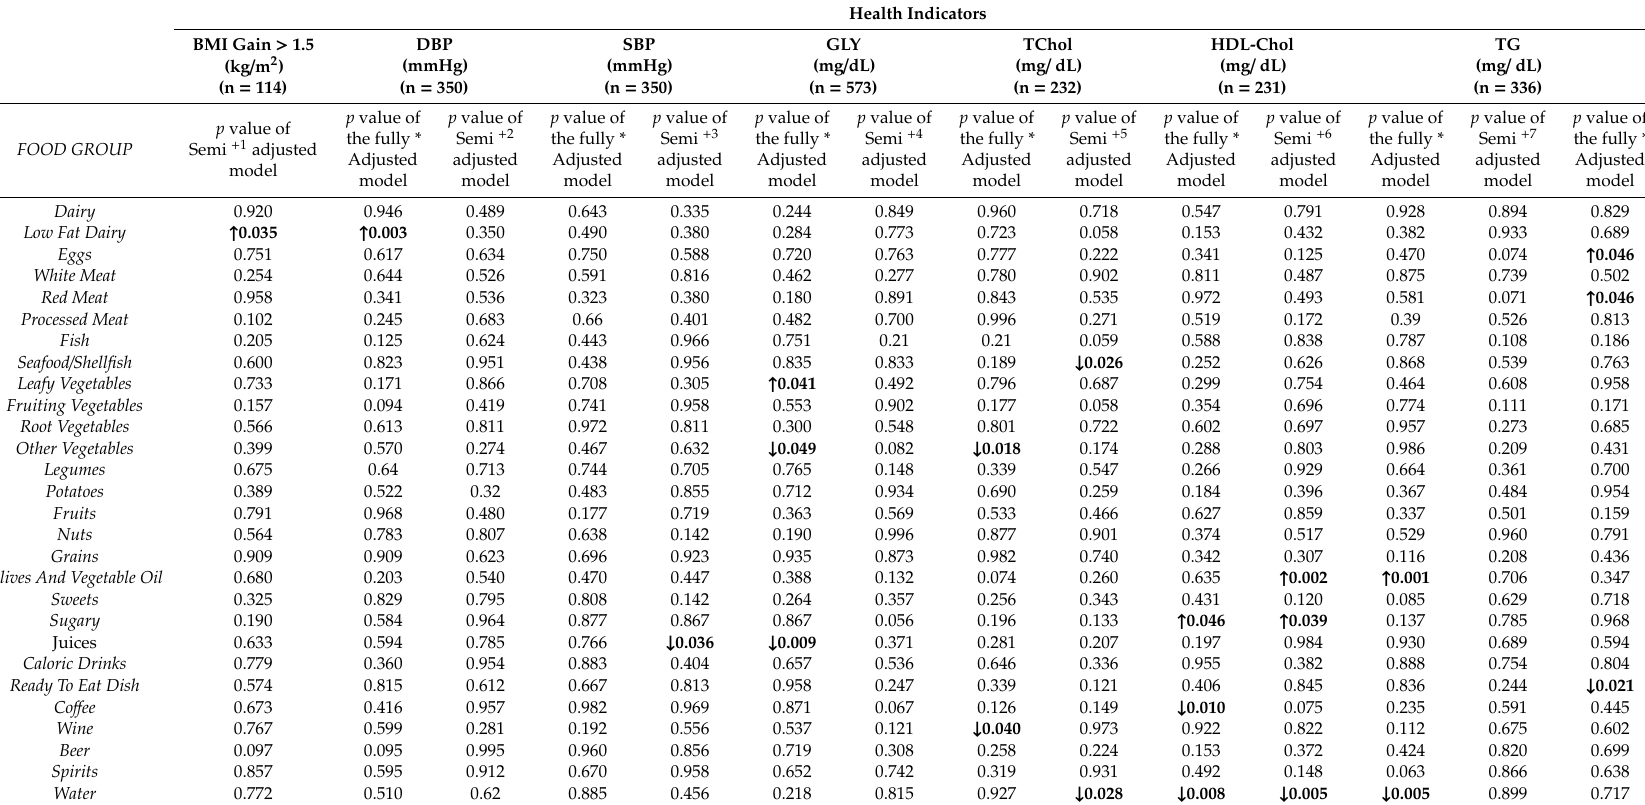
Table 4. p -values of linear regression modelling the relation between intake of food groups in MICOL3 and health indicators at